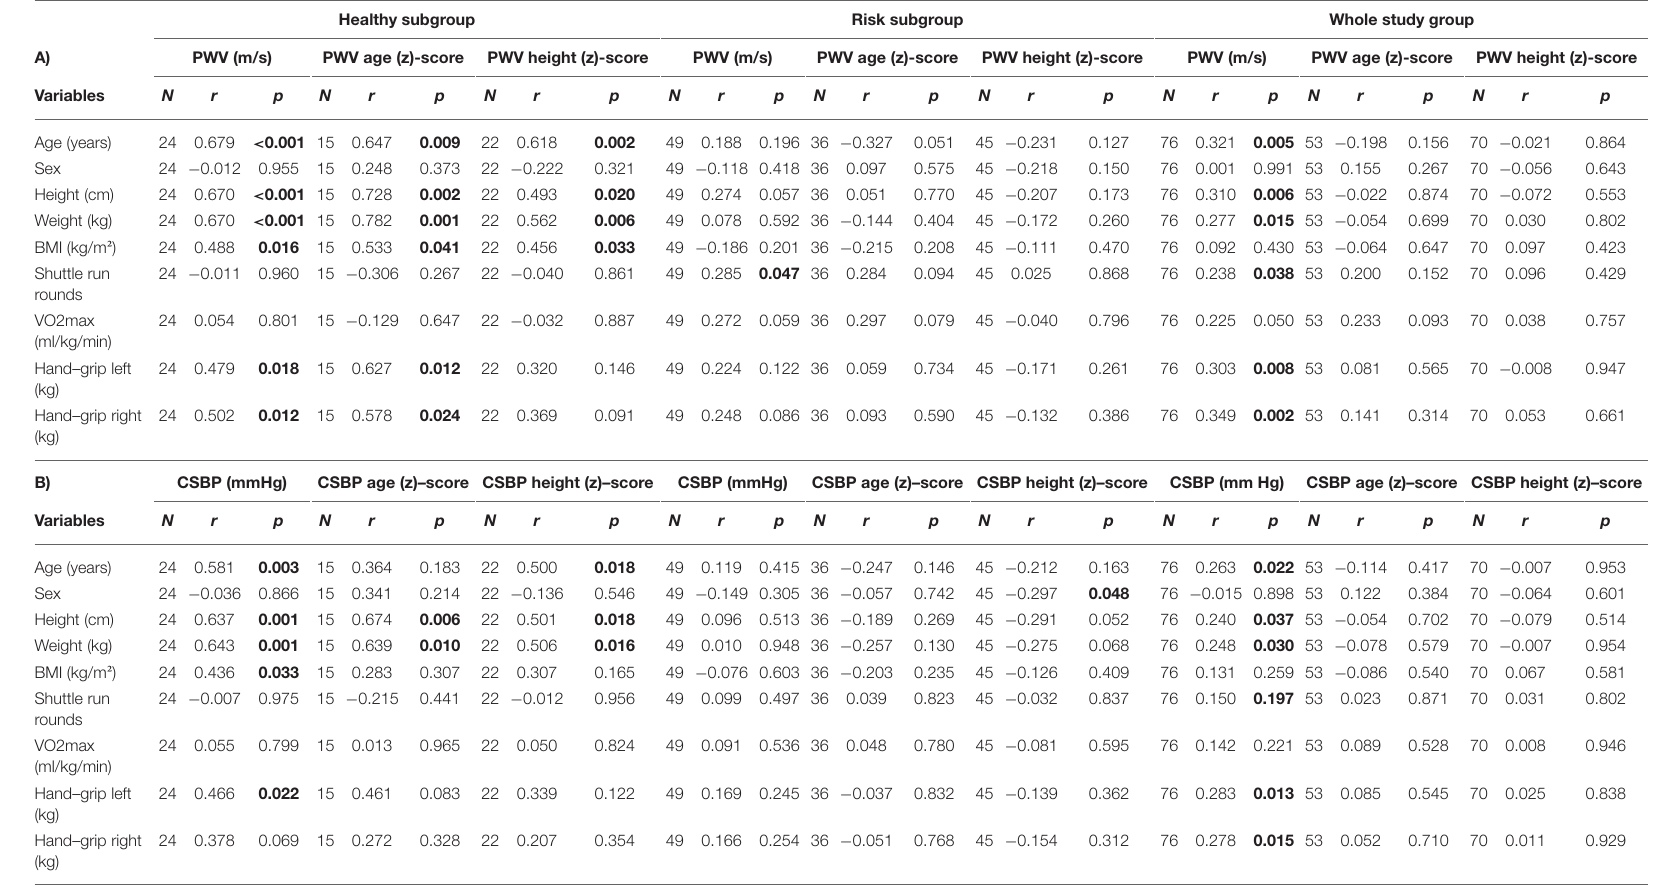
TABLE 5 | Spearman correlation coefficients for A) PWV and B)